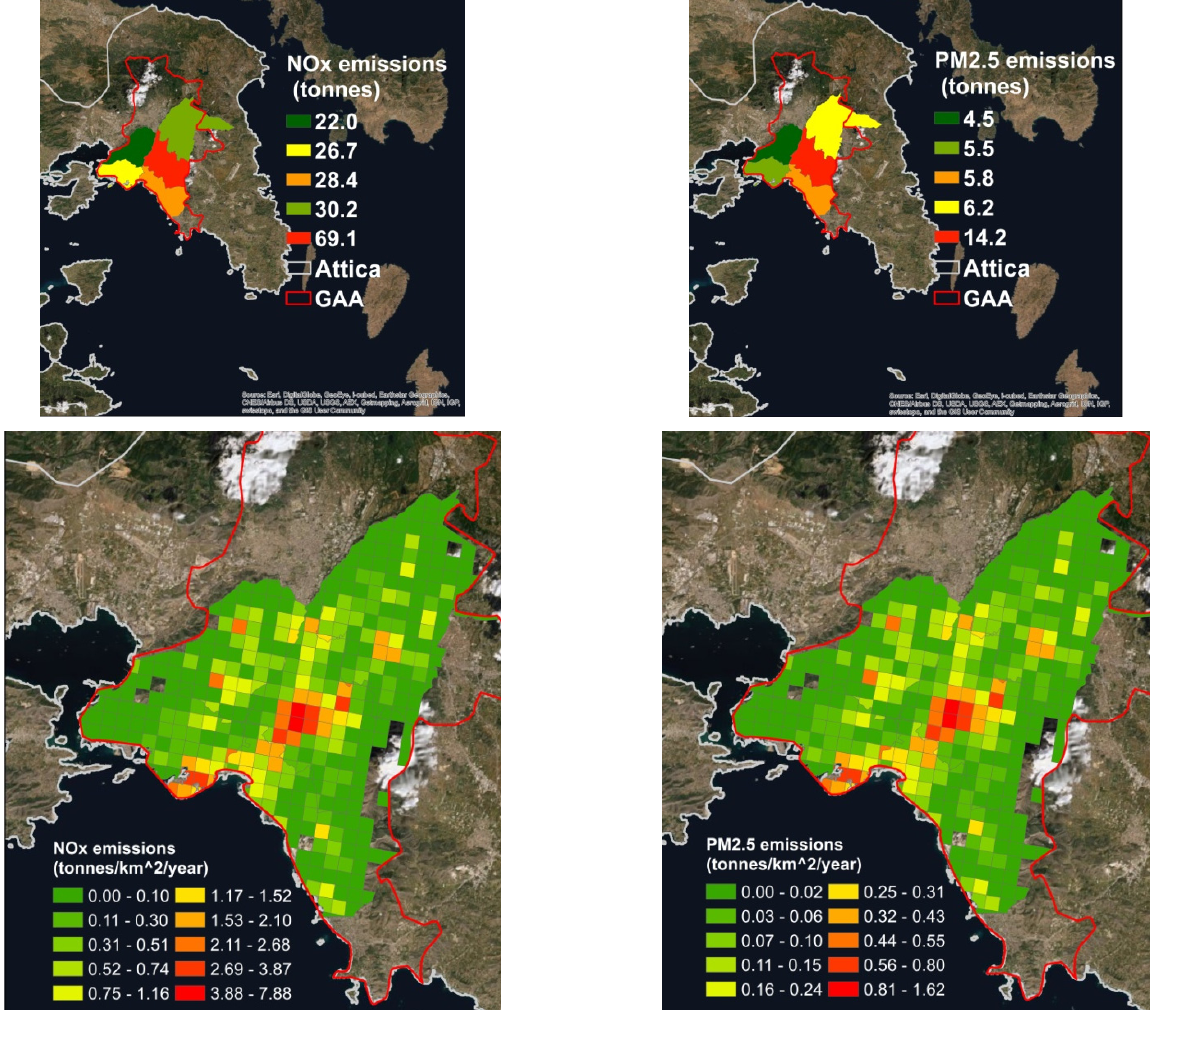
Figure 7. NOx and PM2.5 emissions per regional unit ( top ) and gridded emissions ( bottom ). Table 9. Annual emissions produced by the grilled meat at the GAA. Pollutant Emissions (tn) VOCs Acetonitrile 0.9 Acetone 2.7